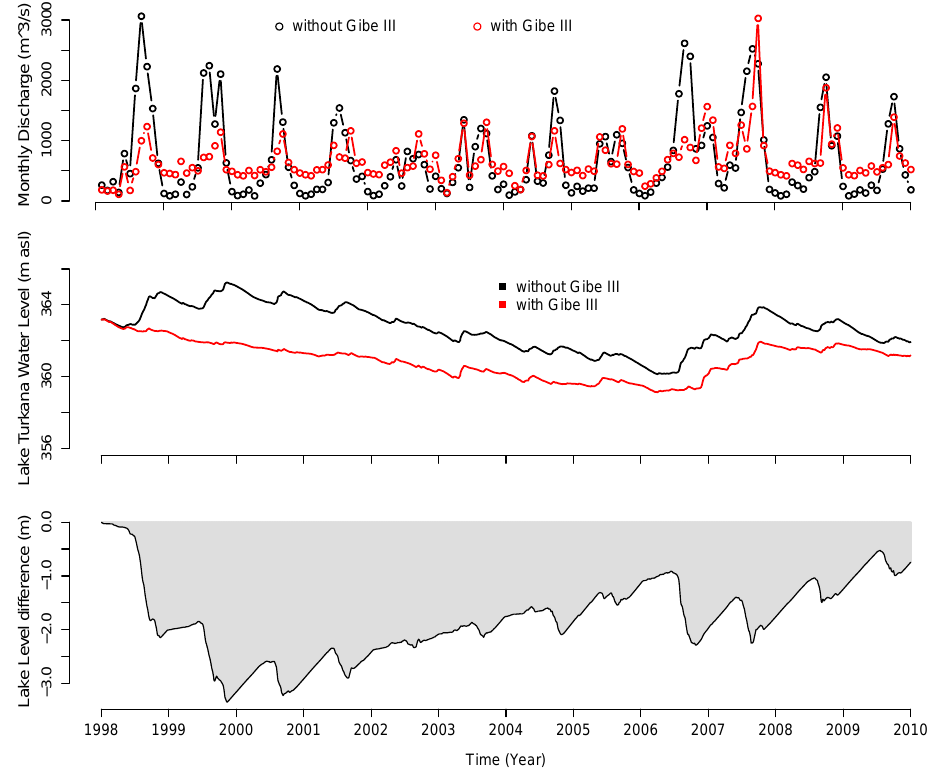
Fig. 3. Impact of the Gibe III dam evaluated using an historical approach. Top: total monthly Lake Turkana inflows; middle: the lake water levels; and bottom: the difference in lake levels. The model was run assuming the dam was commissioned on 1 January